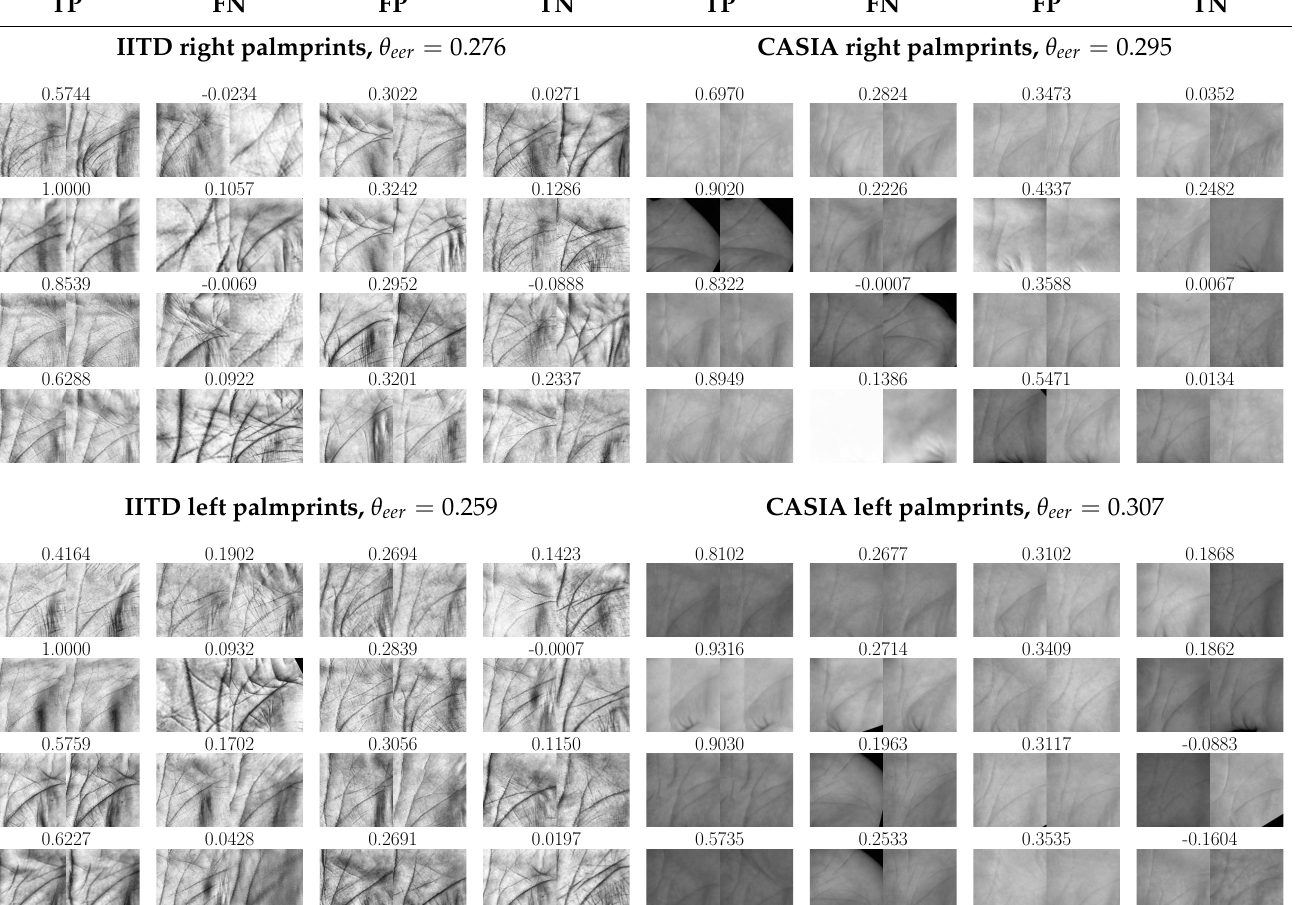
Table 6. Verification results based on the decision threshold θ eer which ensures equal values of FAR and FRR. Image pairs are presented that generated different outcomes in the verification process, i.e., TP-true positives, FN-false negatives, FP-false positives, and TN-true negatives. TP FN FP TN TP FN FP TN IITD right palmprints, θ eer = 0.276 0.5744